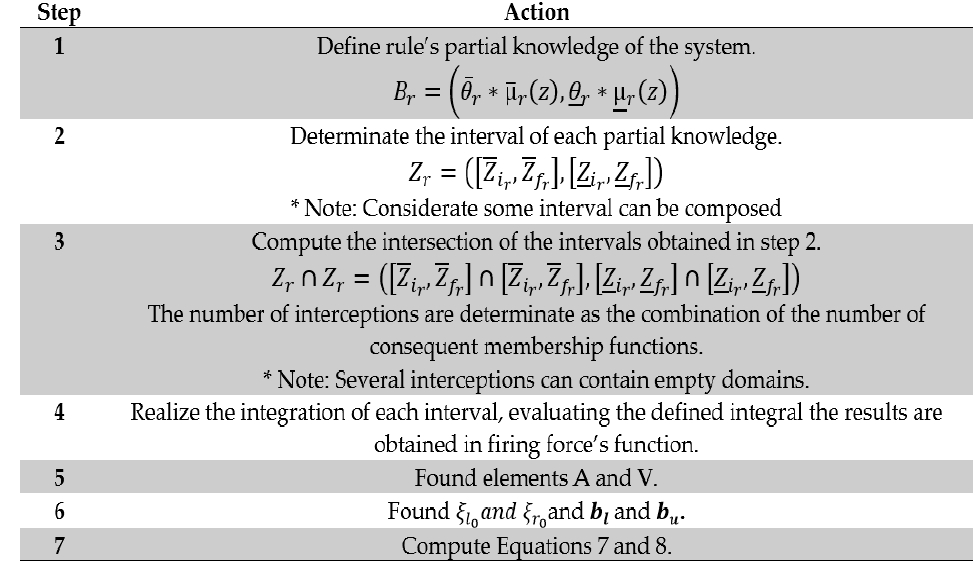
Figure 2. Algorithm for NACEKM.